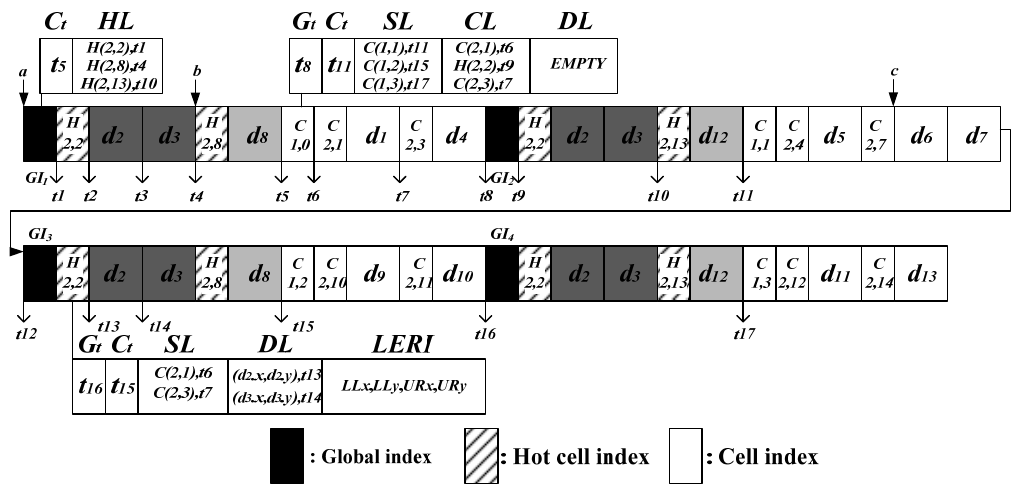
Figure 4. Largest empty rectangle of cell H (2,2).